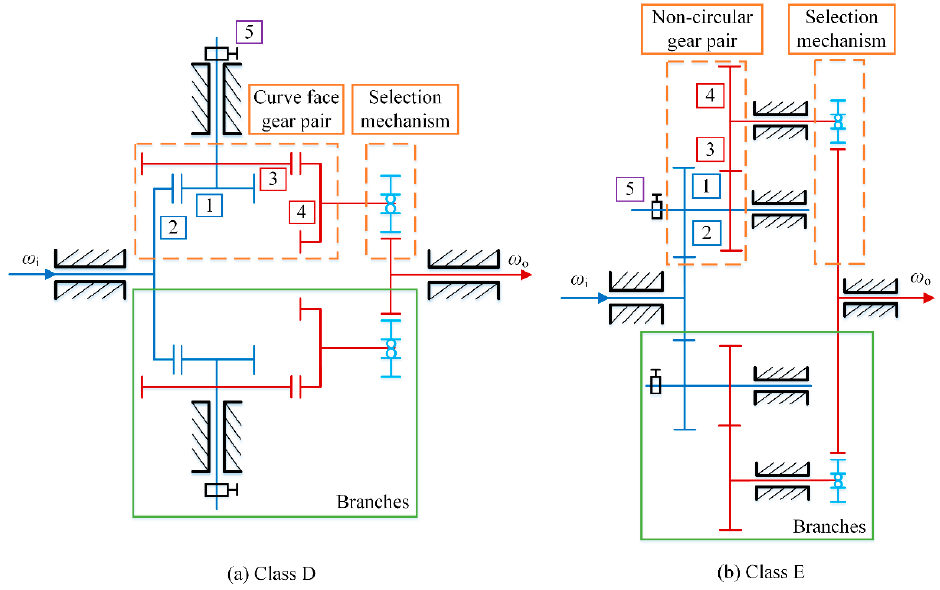
Figure 6. Transmission principle of classes D and E.